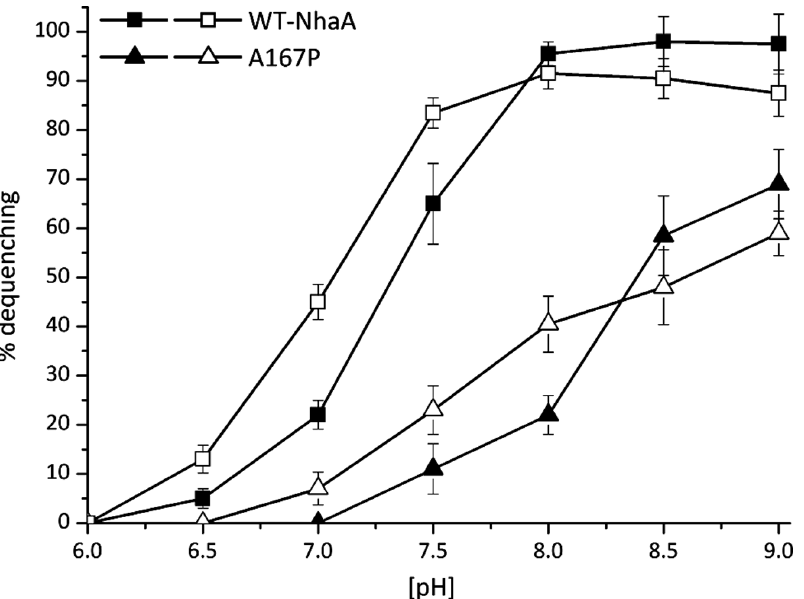
Figure 3. pH dependence of the Na + , Li + /H + antiporter activity in everted membrane vesicles of variant A167P. Everted membrane vesicles were prepared from EP432 cells grown in LBK (pH 7) and expressing WT ( % ) or A167P ( D ). The Na + /H + and Li + /H + antiporter activity was determined in the presence of 10 mM NaCl (filled symbols) or 10 mM LiCl (open symbols) at the indicated pH values, using acridine orange fluorescence to monitor D pH. Results are expressed in % of maximal dequenching of the fluorescence due to cation addition. All experiments were repeated at least three times with nearly identical results.